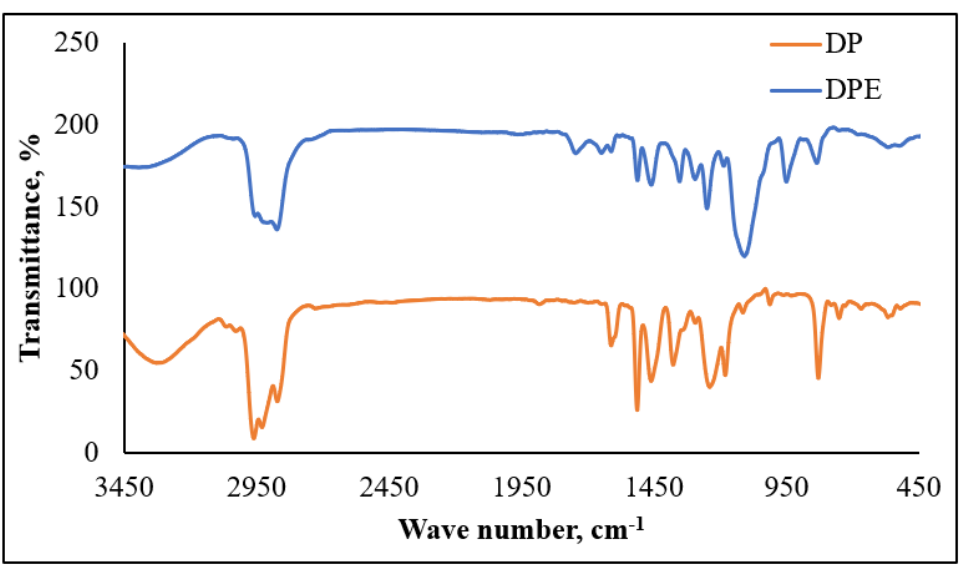
Figure 6. FTIR of dodecyl phenol (DP) and dodecyl phenol ethoxylate (DPE).